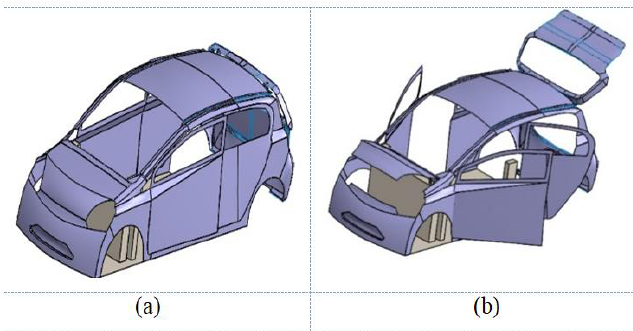
Fig. 10. Motion Study of Daihatsu Mira X (a) Vehicle body with hinges (b) Rotation of individual parts about the hinges